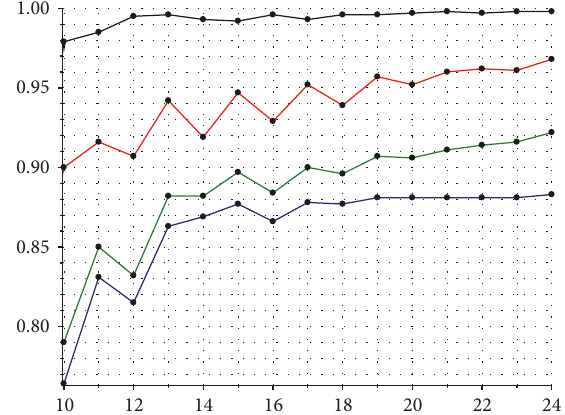
Figure 12: Graph of Table 6 (blue: 𝛼(𝑘,𝑆 𝑏 (𝑛)) , red: 𝛼(𝑘, 𝐵(𝑛)) , green: 𝛼(𝑘,𝐻 (𝑛)) , black: 𝛽(𝑘,𝐵(𝑛),𝑆 𝑏